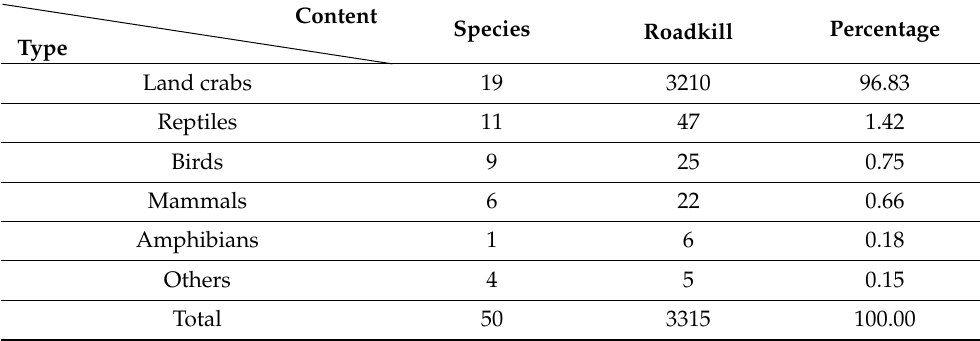
Table 3. Investigation of all roadkill incidents at Banana Bay in